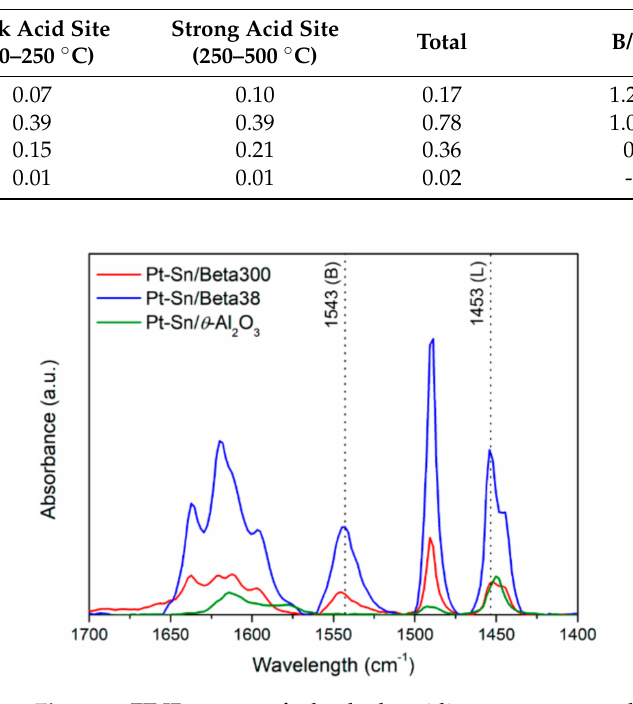
Figure 3. FT-IR spectra of adsorbed pyridine over supported Pt-Sn